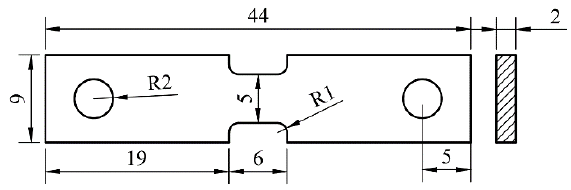
Figure 2. Specimen dimensions used for tensile tests.